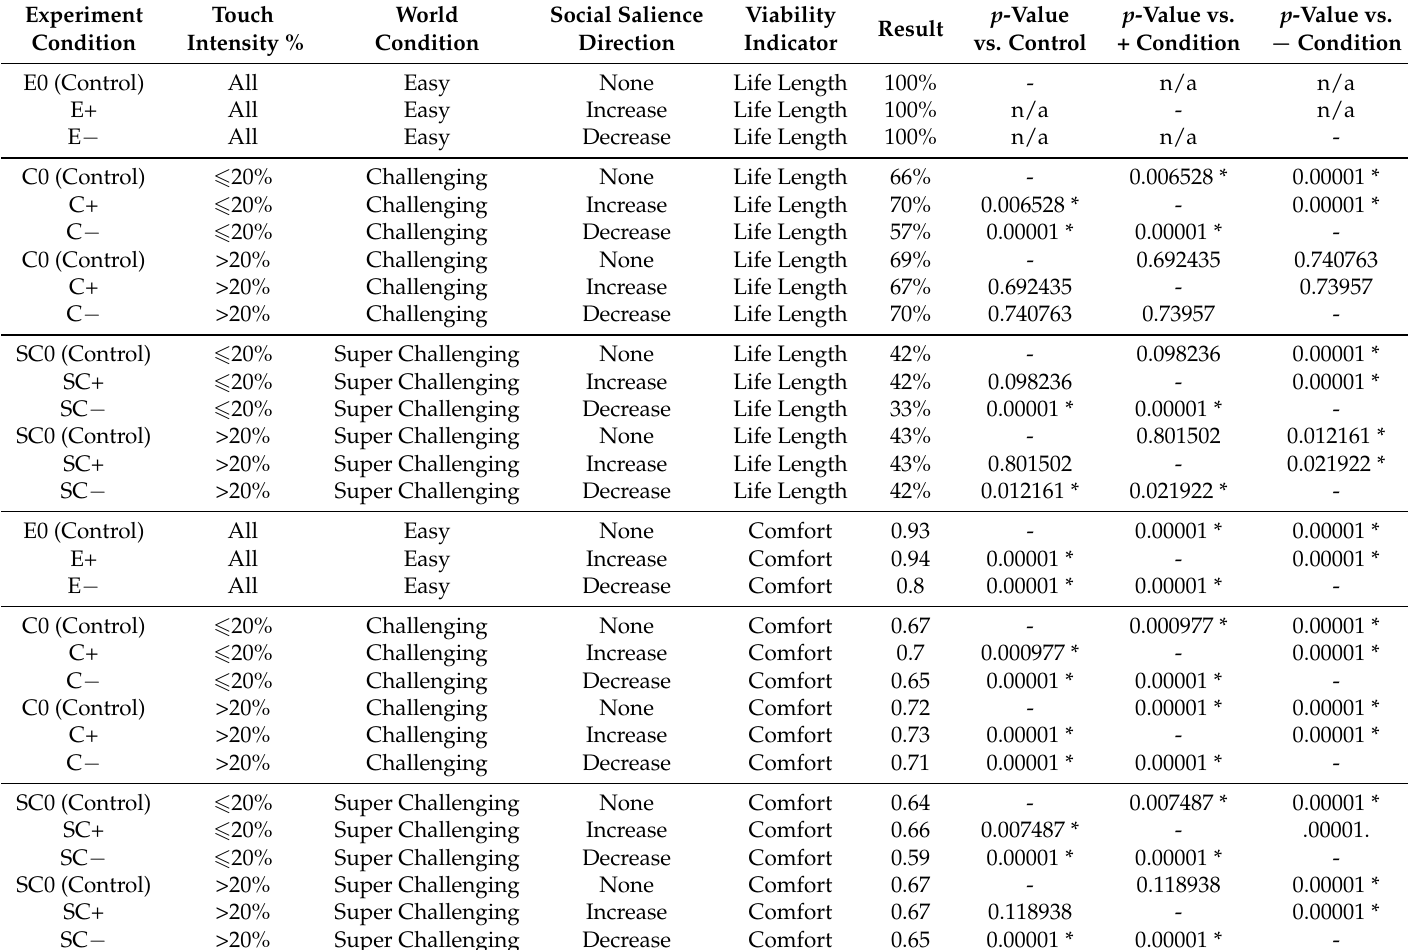
Table 6. Summary of results for Experiment 1, including p -values for all conditions. The p -values are for all results in bucketed touchingIntensity values; * indicates statistical significance, 0 indicates control group with no OT effects, + are Increased Social Salience groups, and − are Decreased Social Salience